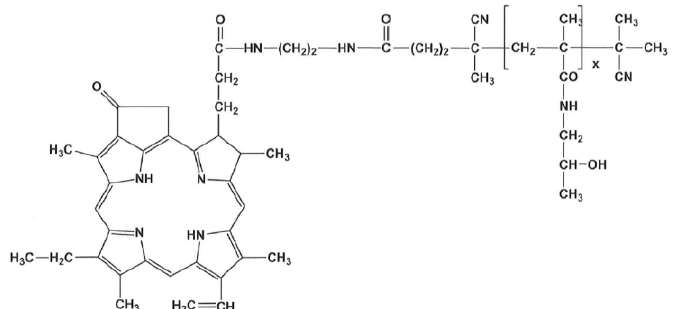
Figure 1. The semitelechelic polyHPMA-pPheo conjugate was used for the experiments in